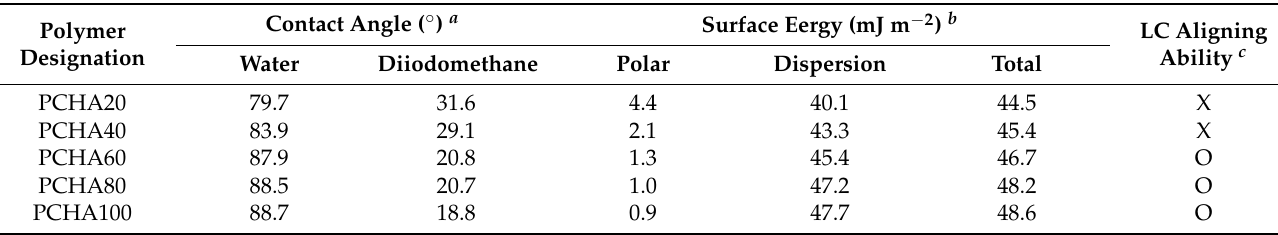
Figure 7. ( a ) Water, ( b ) diiodomethane contact angle and ( c ) surface energy values of PCHA# films according to the molar contents of the chavicol moiety in the side groups. Table 1. Surface energy values and LC alignment properties.